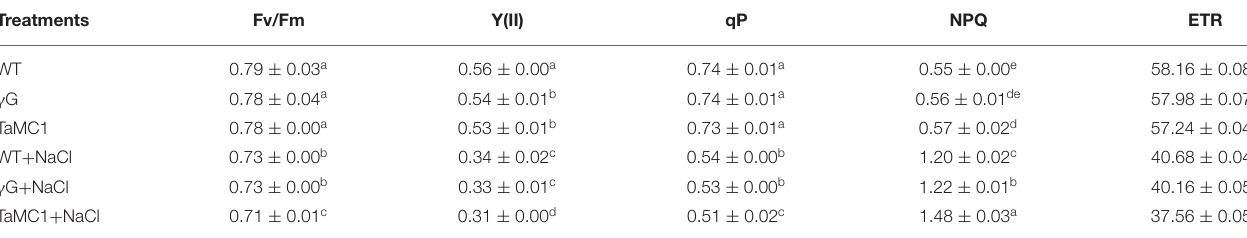
TABLE 1 | The changes in chlorophyll fluorescence parameters in leaves of BSMV - VIGS - GFP - ( γ G), BSMV -VIGS- TaMCA-Id- (TaMC1) -inoculated wheat seedlings and the wild-type seedlings (WT) under NaCl stress.